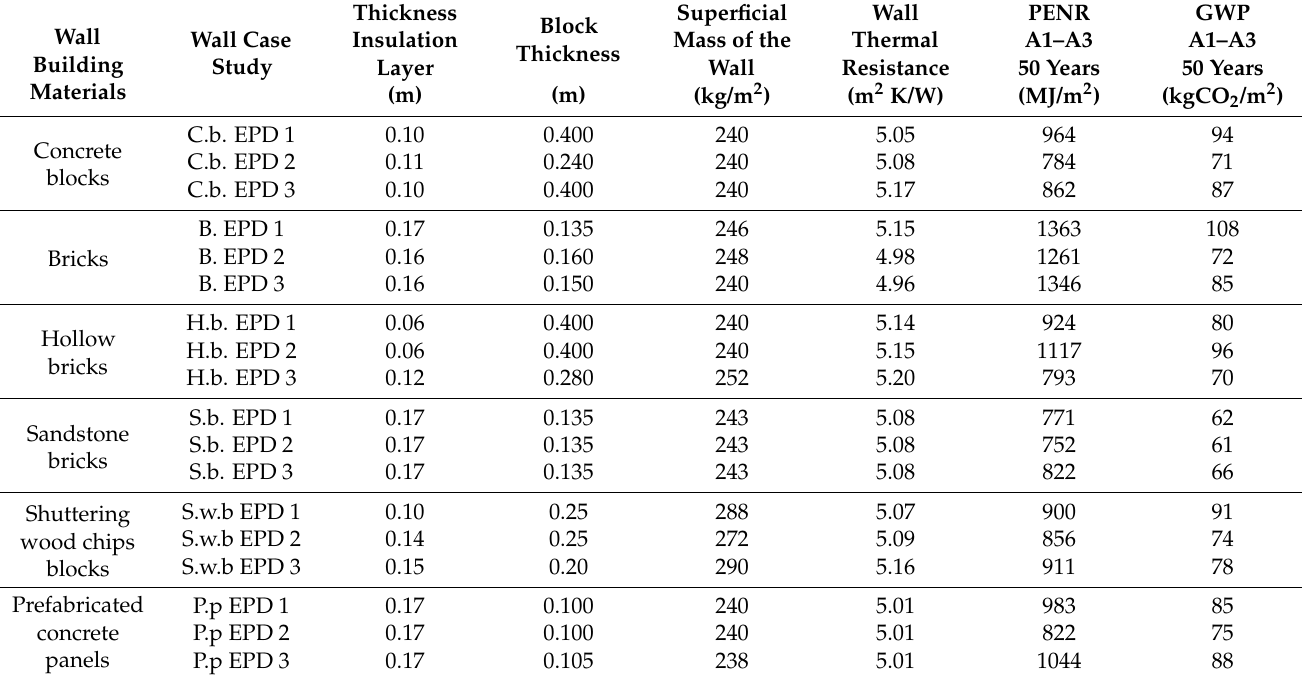
Table 12. Characteristics of the wall options